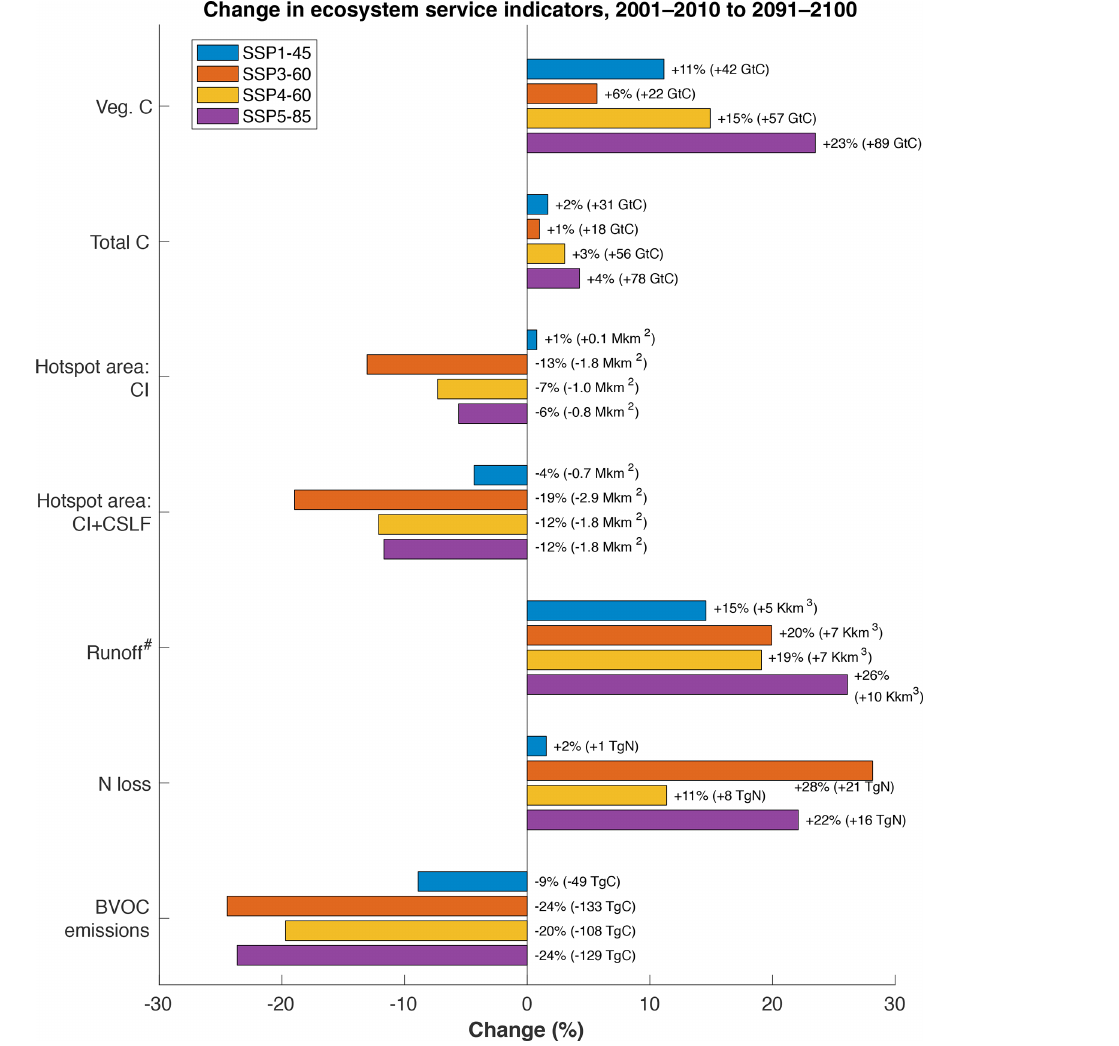
Figure 4. Percent global change in ecosystem service indicators between 2001–2010 and 2091–2100. CSLF: Congolian swamp and lowland forests (see Sect. 3.2.5). # The time periods compared for runoff were 1971–2000 and 2071–2100 due to high temporal